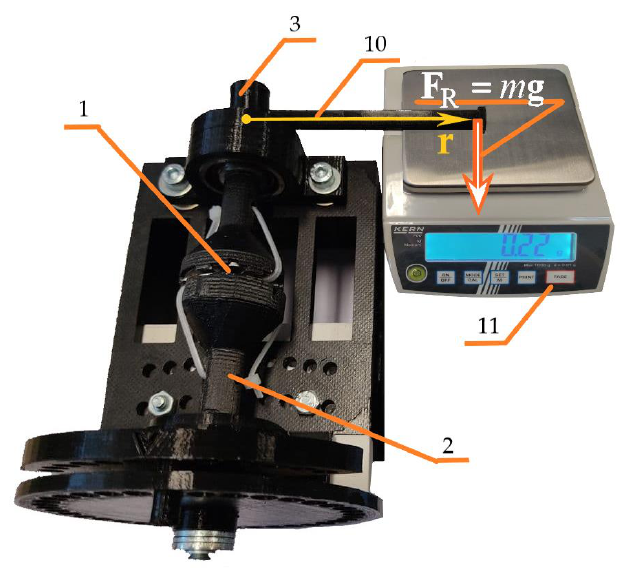
Figure 13. The measurement setup.